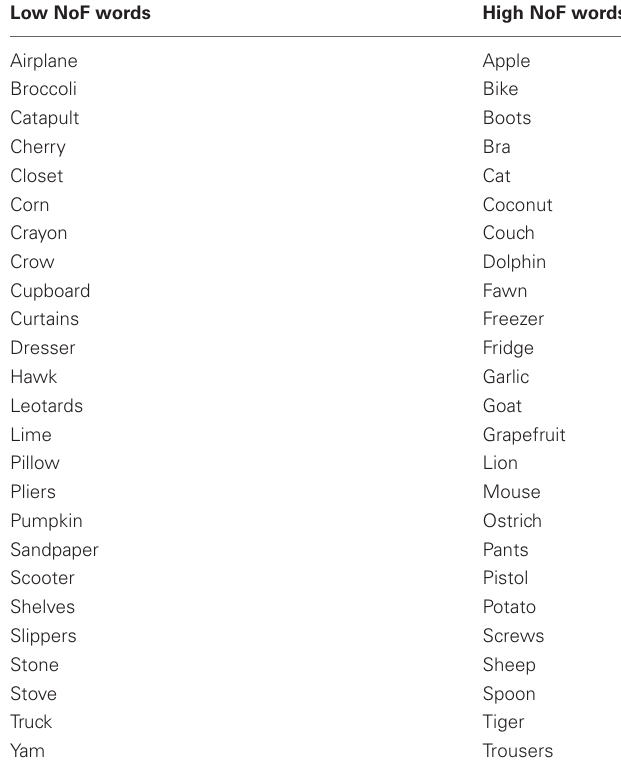
Table A2 | Experiments 2 and